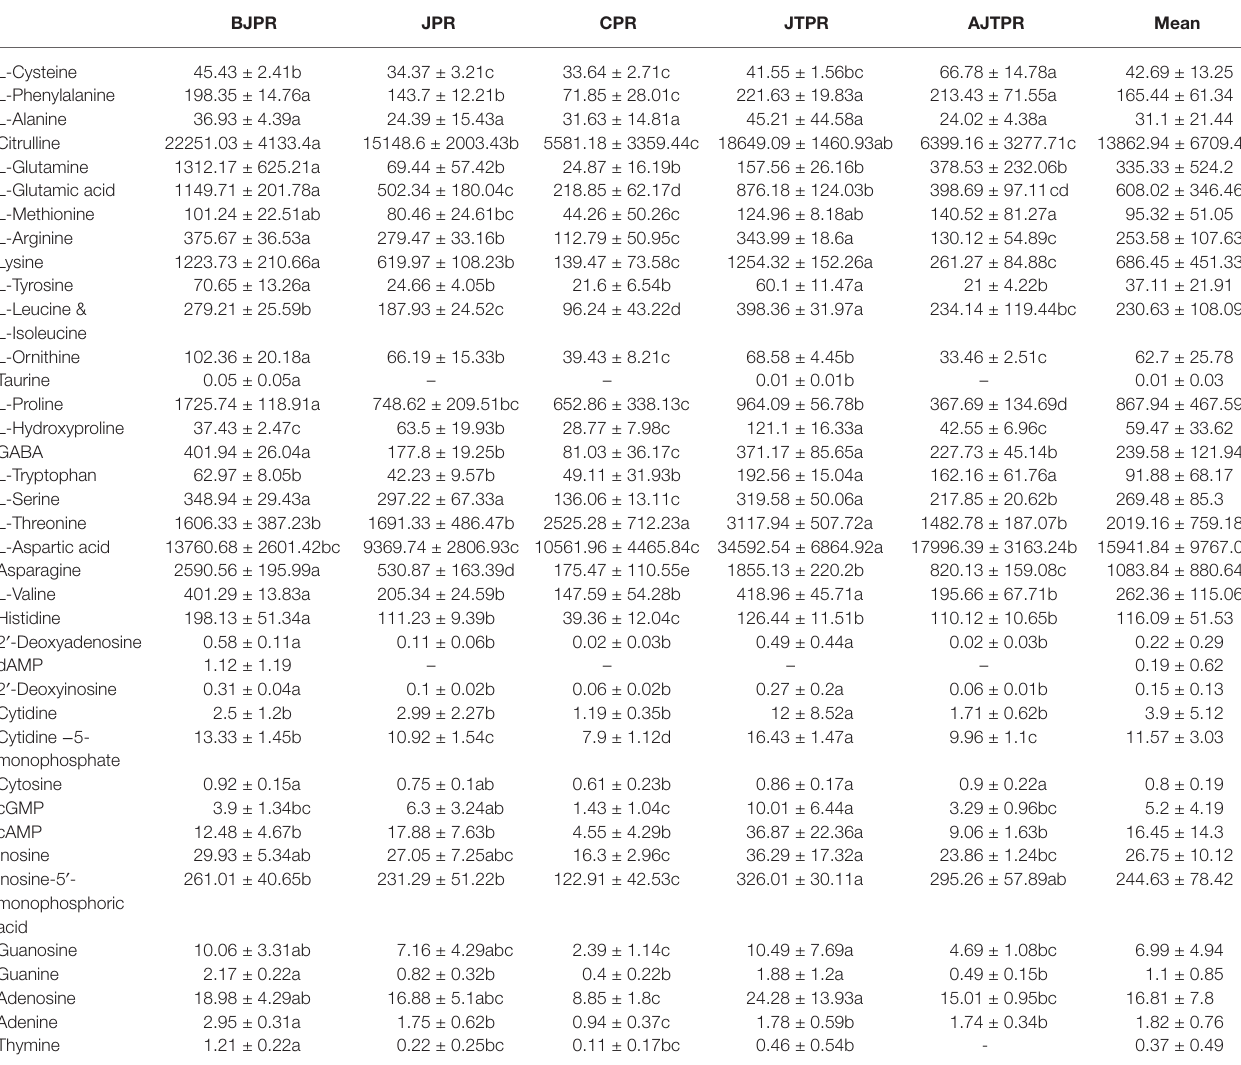
TABLE 1 | Contents of 24 amino acids and 15 nucleosides and nucleobases ( μ g/g) of the five different types of Huangjing. BJPR JPR CPR JTPR